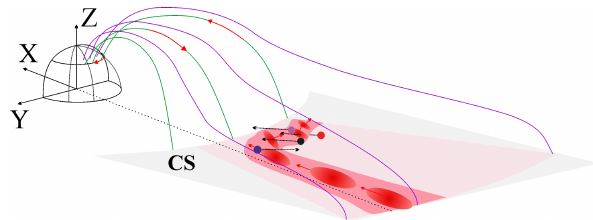
Figure 7. A diagram of the observed magnetic structure of the flux pile up region in the near-Earth PS. An area shaded light pink rep- resents the perturbed CS. The localized area shaded dark pink dis- plays a channel in which the multiple BBFs with the embedded DFs (shown by red ovals) propagate. The direction of DFs’ motion is shown by red arrows. P3 probe and Cluster spacecraft are shown by colored dots and their trajectories during the event are shown by black dotted arrows. Near the P3 and Cluster locations the multiple BBFs are braked and diverted. The system of field-aligned currents and westward electrojet is shown by red arrows.